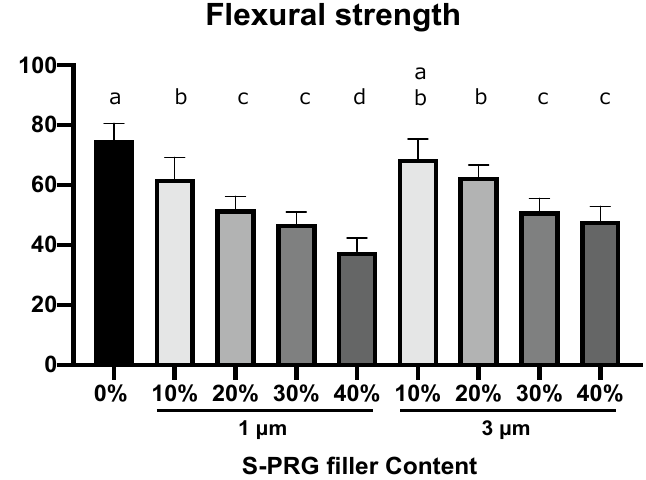
Figure 1. Representative scanning electron microscopy (SEM) images of ( A ) surface pre-reacted